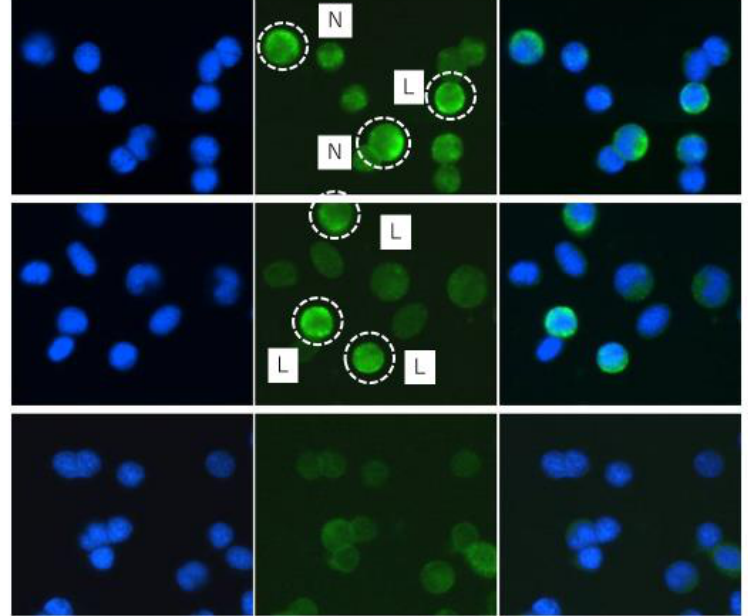
Figure 1. Fluorescent In Situ Hybridization (FISH) with the AhR probe (AhR2α + β) on the immune cells isolated from peripheral blood. Left: fluorescent nuclear staining with DAPI (blue), middle: fluorescent AhR mRNA staining (green), right: merge of nuclear and AhR-RNA staining. The first and second line show cells hybridized with the AhR-antisense probe (positive probe), the third line shows cells stained with the AhR sense probe (negative probe). The circles indicate positive immune cells: L = lymphocyte-like morphology; N = larger polymorphonuclear cells ressembling neutrophils.